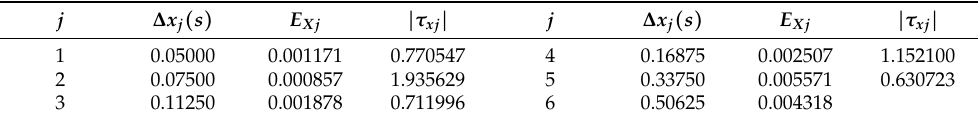
Table 3. Rates of convergence of our numerical scheme in terms of spatial ( x ).